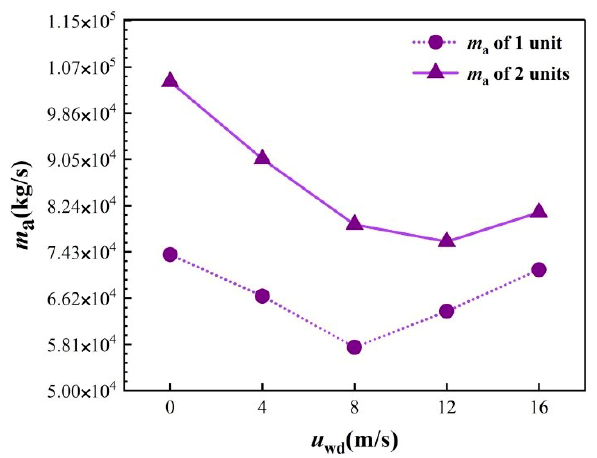
Figure 19. Air mass flow rates of NDDCS with one tower in the cases of 2 units and 1 unit under typical crosswind speeds.